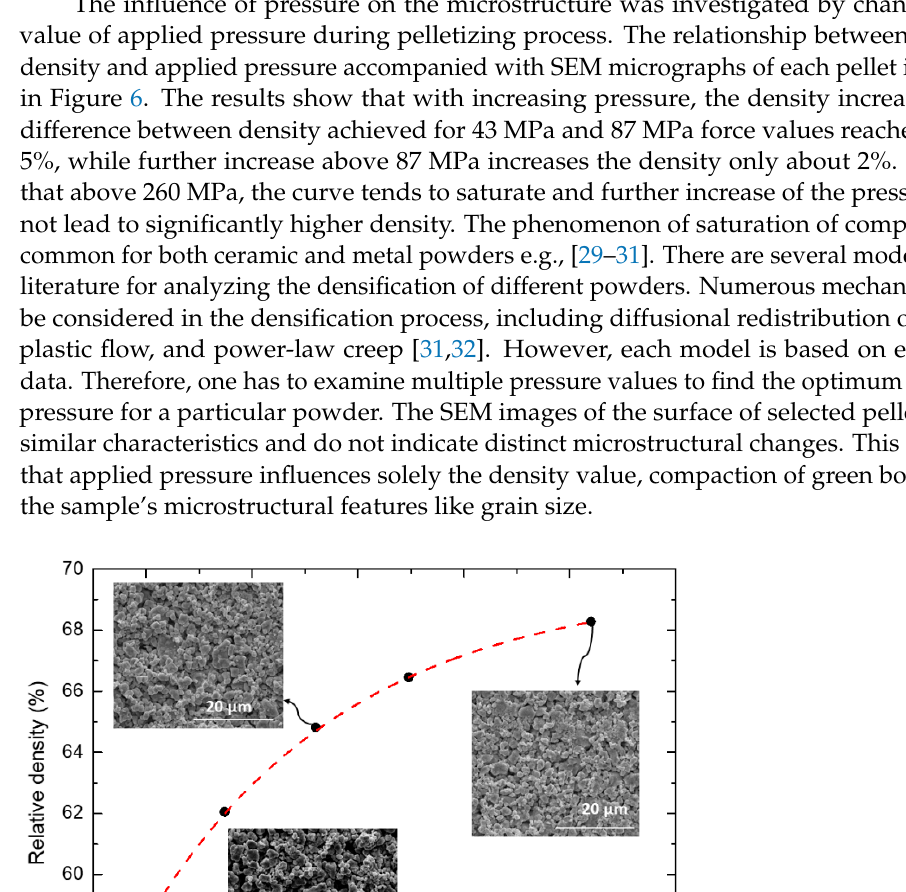
Figure 7. The SEM images, grain size distribution, and relative density ρ r of ceramics annealed at ( a ) 1000 °C, ( b ) 1100 °C, and ( c ) 1200 °C. In the second approach, the samples were annealed for 6 h, 12 h, and 24 h at the same temperature—1100 °C. The results are summarized in Figure 8 and show relatively small changes in the relative density of samples. Interestingly, for the longest time of annealing, the sample has not achieved the highest density. However, the maximum change of relative density is 4%, which is close to the uncertainty of the measurement (above 2%). This indicates that the densification occurs in a time shorter than 6 h and a